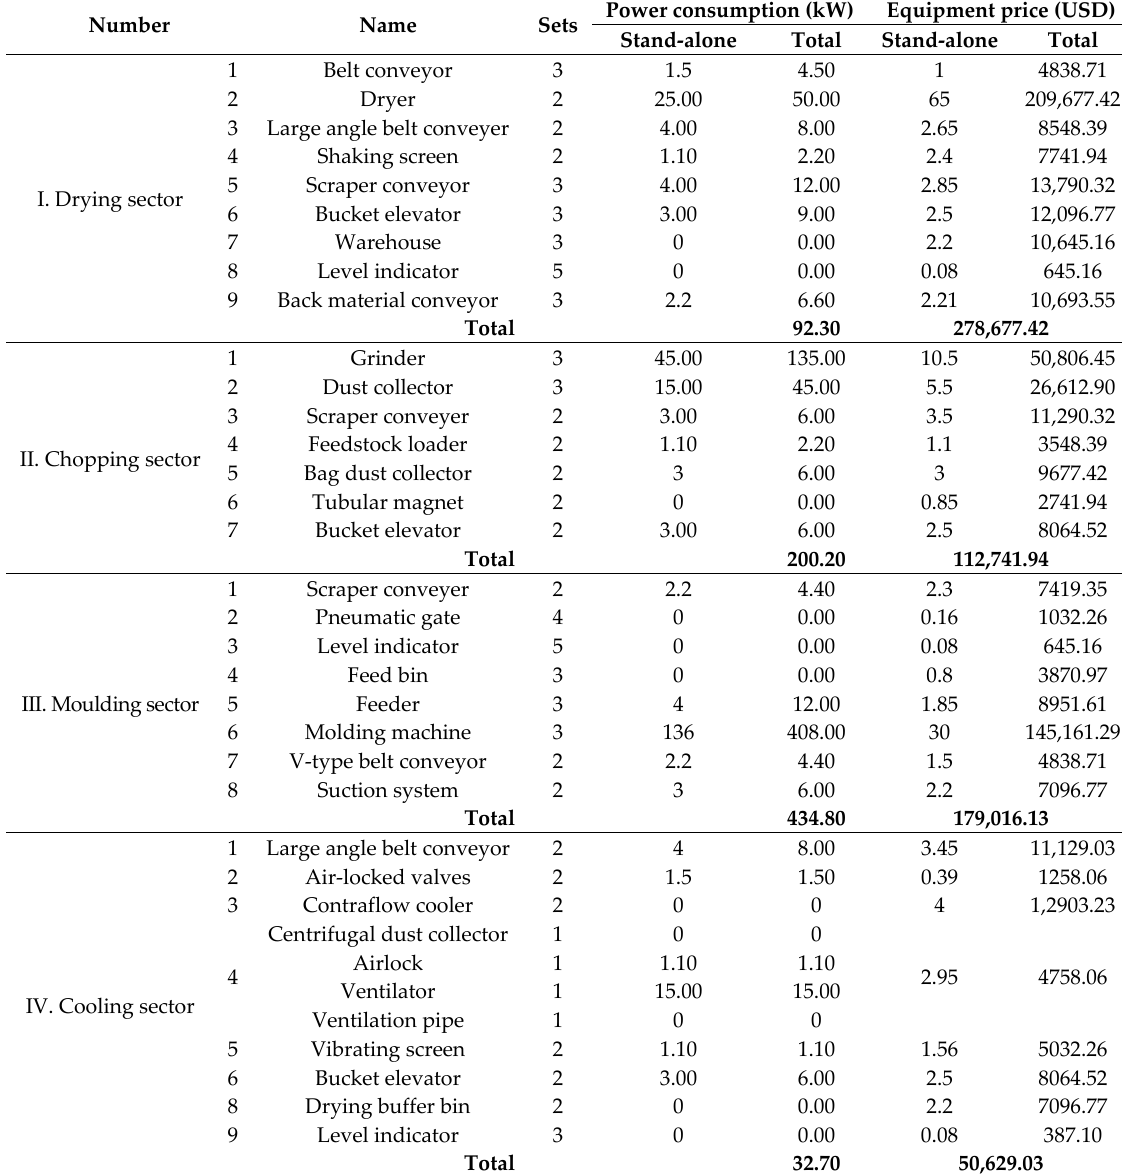
Table 4. Production system parameters of a 20,000 t/a